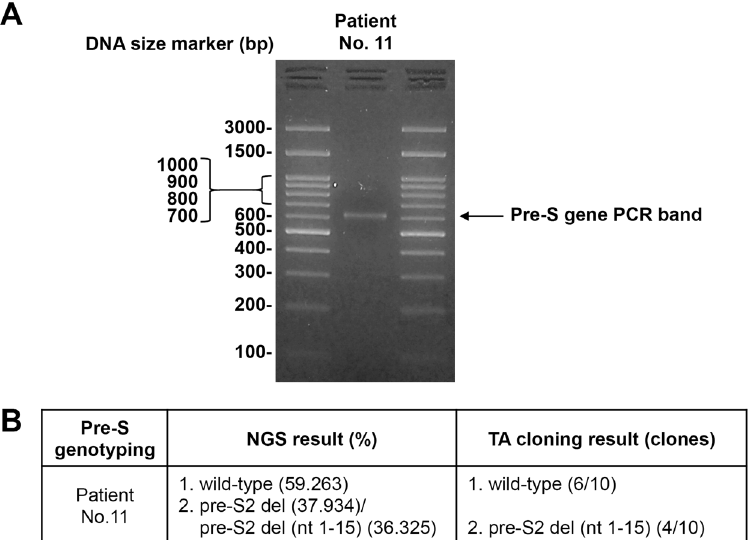
Figure 2. The pre-S genotyping result by additional TA cloning-based analysis in selected HBV-related HCC patient. ( A ) The pre-S gene PCR products prepared from the plasma DNA of the selected patient No. 11 were resolved by agarose gel electrophoresis with the 100-bp DNA size marker loaded on both sides. The single pre-S gene PCR band was indicated by arrow. The size of the marker was shown in base pairs. ( B ) Following TA cloning of the single pre-S gene PCR band, 10 plasmid clones containing the pre-S insert-DNA were randomly selected for Sanger DNA sequencing analysis. The result was shown as the ratio of the number of clones containing either wild-type or deletion pre-S gene DNA to the total number of clones sequenced. The NGS result was shown for comparison. For simplicity, only the pre-S wild-type or deletion whose total frequency was above the cut-off percentage value was shown. The pre-S gene DNA with the highest frequency in the indicated type of pre-S deletion and its deletion region was also shown. Abbreviations: bp, base pairs; del, deletion; nt,